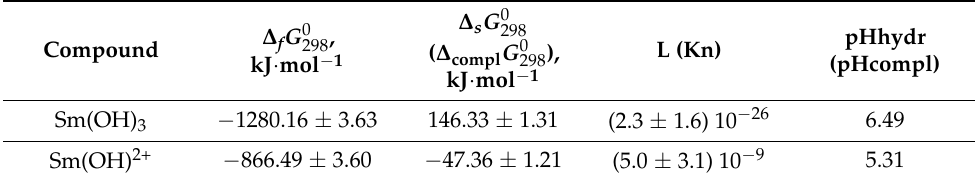
Table 2. Thermodynamic characteristics of Sm (3+) hydroxo compounds.